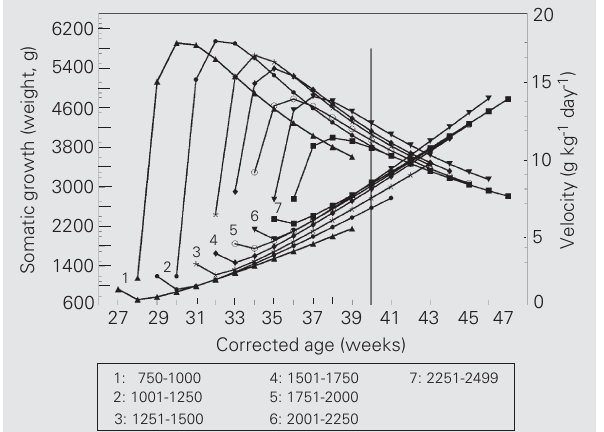
Figure 5. Growth dynamics of adequate-for-gestational-age preterm new- borns (curves 1 and 7): somatic growth and velocity with respect to corrected age.